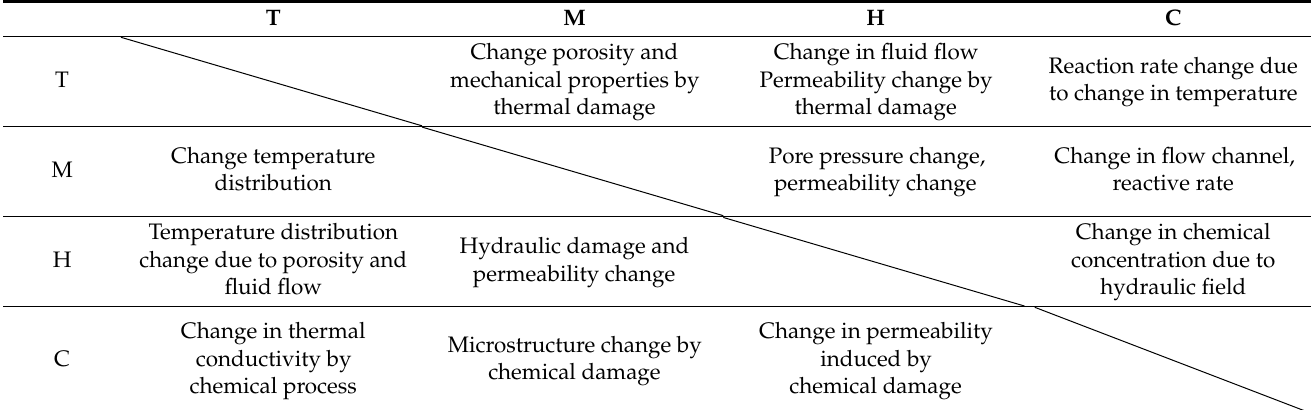
Table 2. Interaction between multi-physical fields.